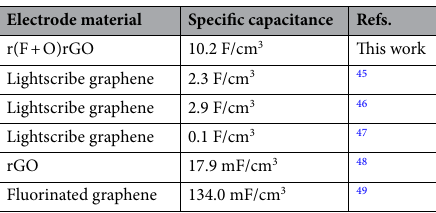
Table 2. Performance comparison of different lightscribe graphene-based supercapacitors.